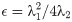
Impact of the CG potential E(X; λ) on the 500-bead model of Arp2/3.(A) RDF of the models computed with Boltzmann prior (solid line, grey fill) and without the Boltzmann prior (dashed line). (B) Sampled force field parameters λ1 and λ2. (C) Posterior distribution of the interaction range σ. (D) Posterior distribution of the depth of the potential well ϵ=λ12/4λ2.